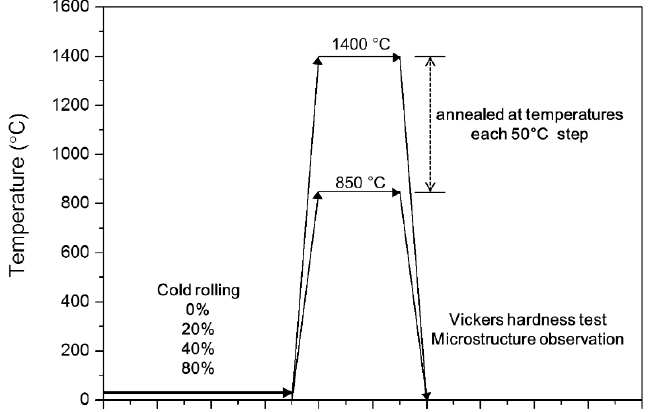
Figure 2. Schematic view of cold rolling direction and the extrusion direction (ED): ( a ) the ED is parallel to the RD, and ( b ) the ED is parallel to the transverse direction (TD). Most of the rolling directions are the case ( a ) in this study except for mentioning. ND is the normal direction of rolling surface.